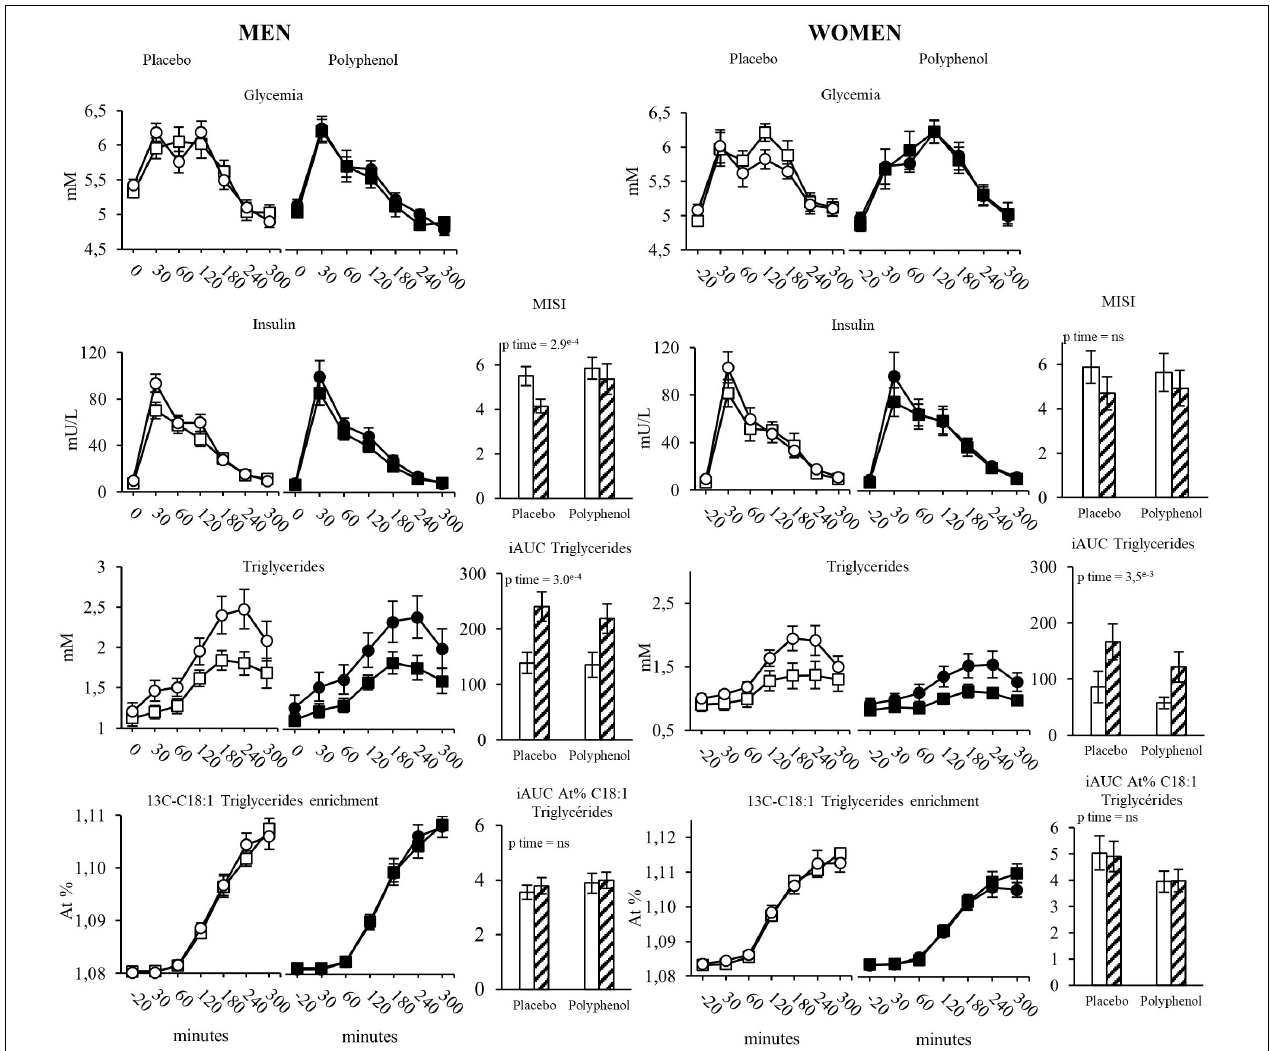
FIGURE 2 | Evolution of glycemia, insulinemia, triglycerides and 13C-C18:1 triglycerides in plasma during the test meal, in men and women in the placebo and the polyphenol groups. MISI: Matsuda insulin sensitivity index, iAUC in each group are represented before and after overfeeding. White squares: Placebo group at baseline; White circles: Placebo group after overfeeding; Black squares: Polyphenol group at baseline; Black circles: Polyphenol group after overfeeding; White bars: Baseline; Hatched bars: Overfeeding. Data are expressed as mean ±